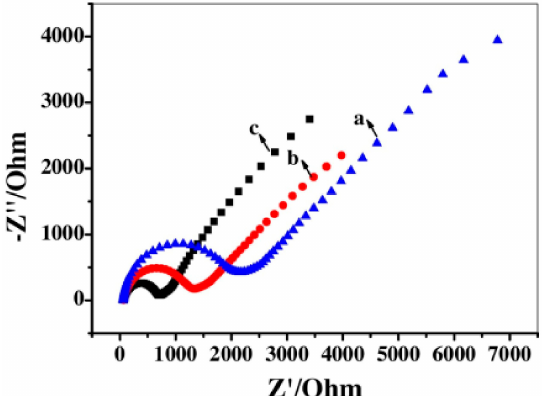
Figure 7. Nyquist plots recorded for unmodified GCE (a), AChE / CS-MXene / GCE (b), CS-MXene / GCE (c) in 5 mM K 3 [Fe(CN) 6 ] and 0.1 M KCl mixture solution over a frequency range from 10 − 2 Hz to 10 5 Hz. CS stands for chitosan. Reprinted from ref. [63], Copyright (2017), with permission from